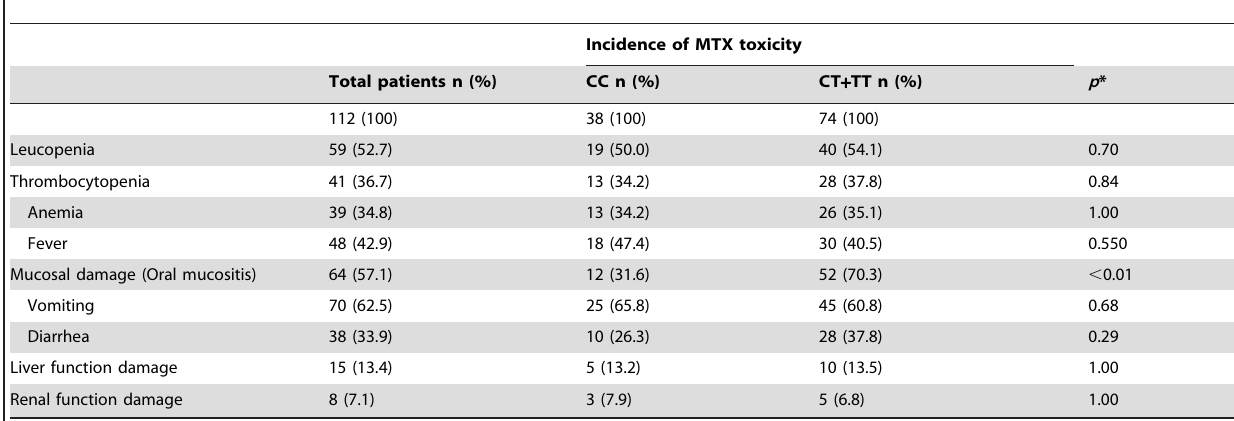
Table 4. Incidence of methotrexate (MTX) toxicity by ATP-binding cassette subfamily C member 2 ( ABCC2 ) gene 2 24C . T genotype.